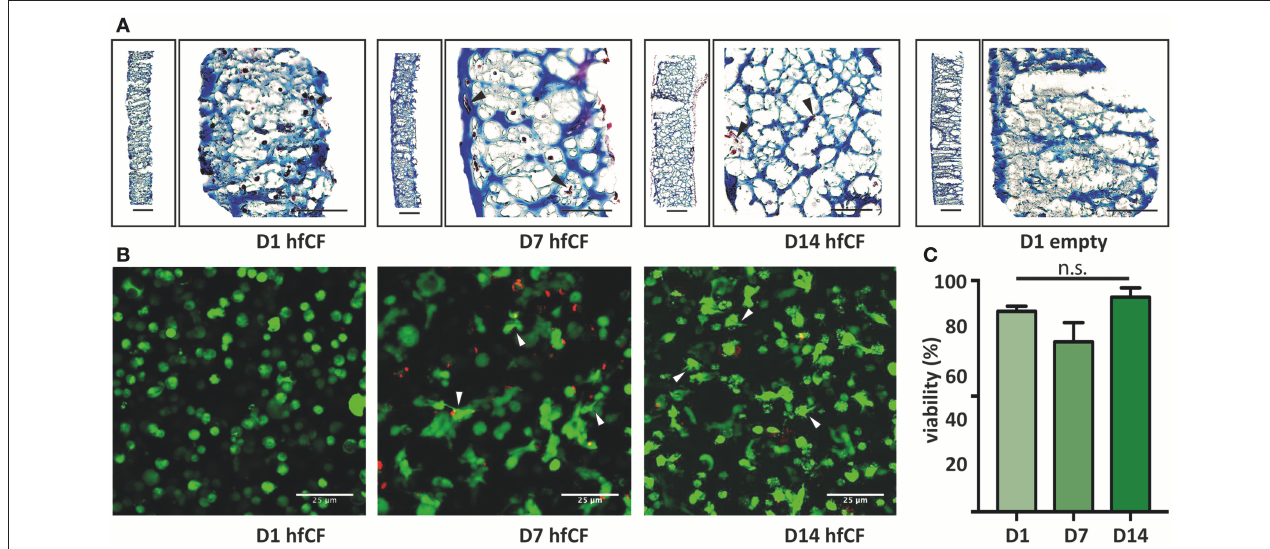
FIGURE 2 | Encapsulation of human fetal cardiac fibroblasts in GelMA hydrogel. (A) Trichrome blue staining demonstrates homogenous encapsulation of hfCF in the 10% GelMA hydrogel. Blue = extracellular matrix and scaffold (GelMA). Dark red = hfCF. (B) Live/Dead staining shows that cells remain viable in the 10% GelMA hydrogels until 14 days in culture. Directly after encapsulation, cells display a round morphology, whereas after 7 days cells appear more elongated and attached to the matrix (arrowheads). Live cells = green. Dead cells = red. Scale bars = 25 µ m. (C) Semi-quantitative analysis of the number of live cells ( n = 5). Statistical significance was assessed using one-way